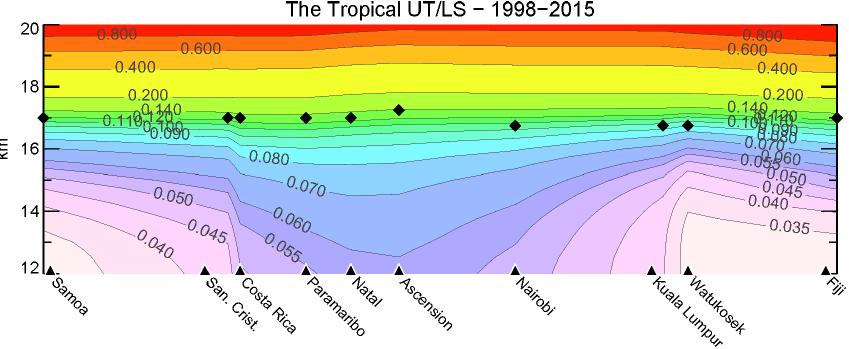
Figure 9. TTL ozone structure (ozone contour lines in ppmv) from SHADOZ from 13–17.5km above the stations, labelled by their location, equatorward of 19 ◦ N/S based on all 1998–2015 data. Courtesy: Jacquelyn C. Witte,